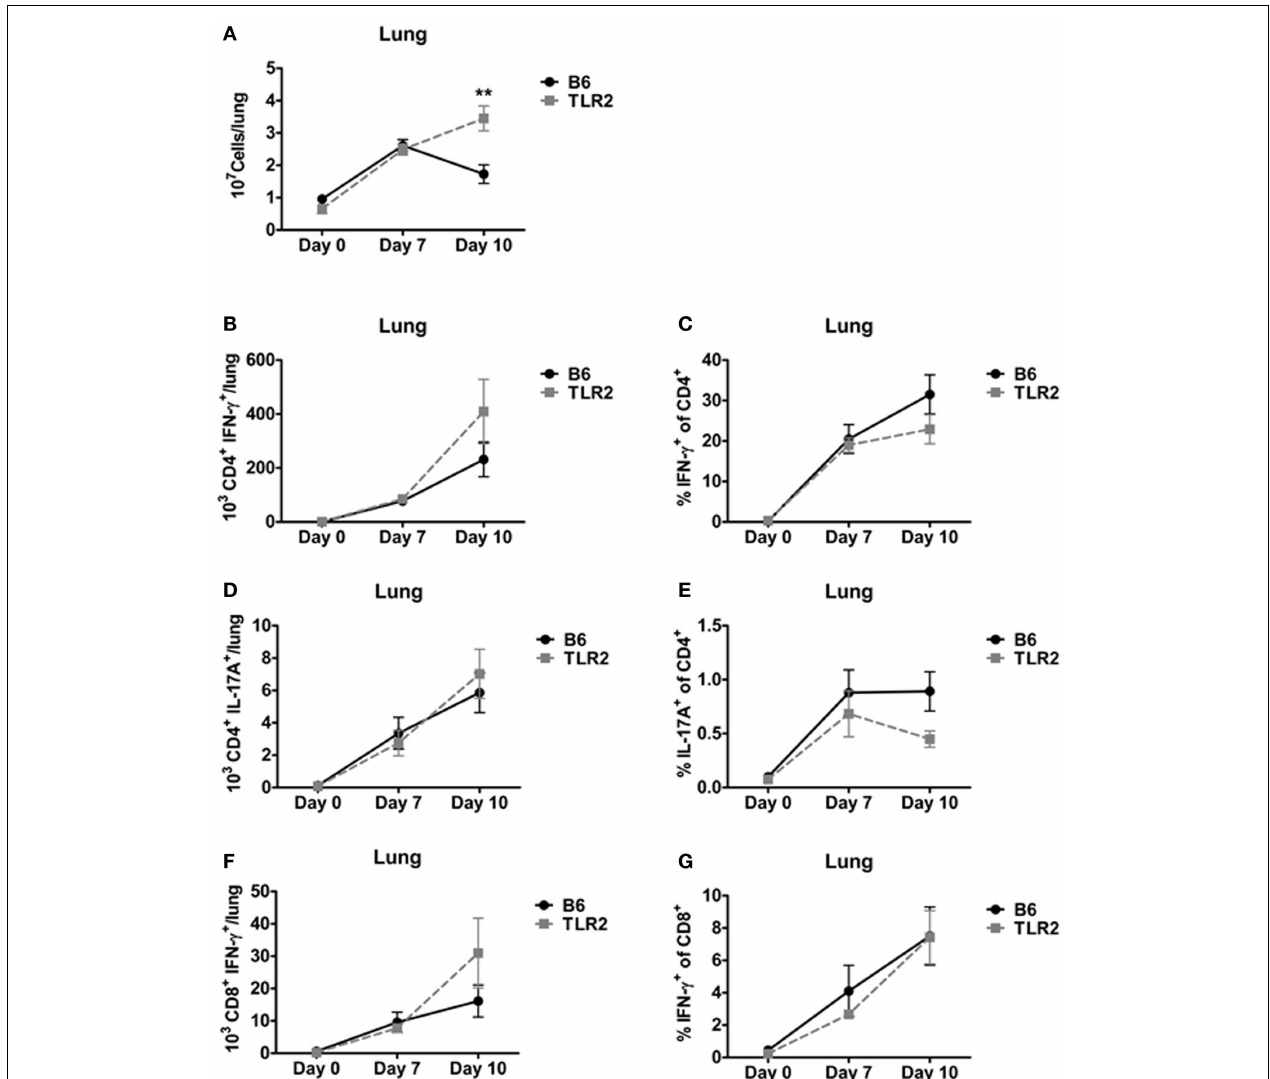
culture. Flow cytometry was used to determine the (B) total number of CD4 + IFN- γ + T-cells, (C) % IFN- γ + of CD4 + T-cells, (D) total number of CD4 + IL-17A + T-cells, (E) % IL-17A + of CD4 + T-cells, (F) total number of CD8 + IFN- γ + T-cells, and (G) % IFN- γ + of CD8 + T-cells. Data are combined from at least two independent experiments per time point. n = 4–6 mice/group. Statistical significance was determined using